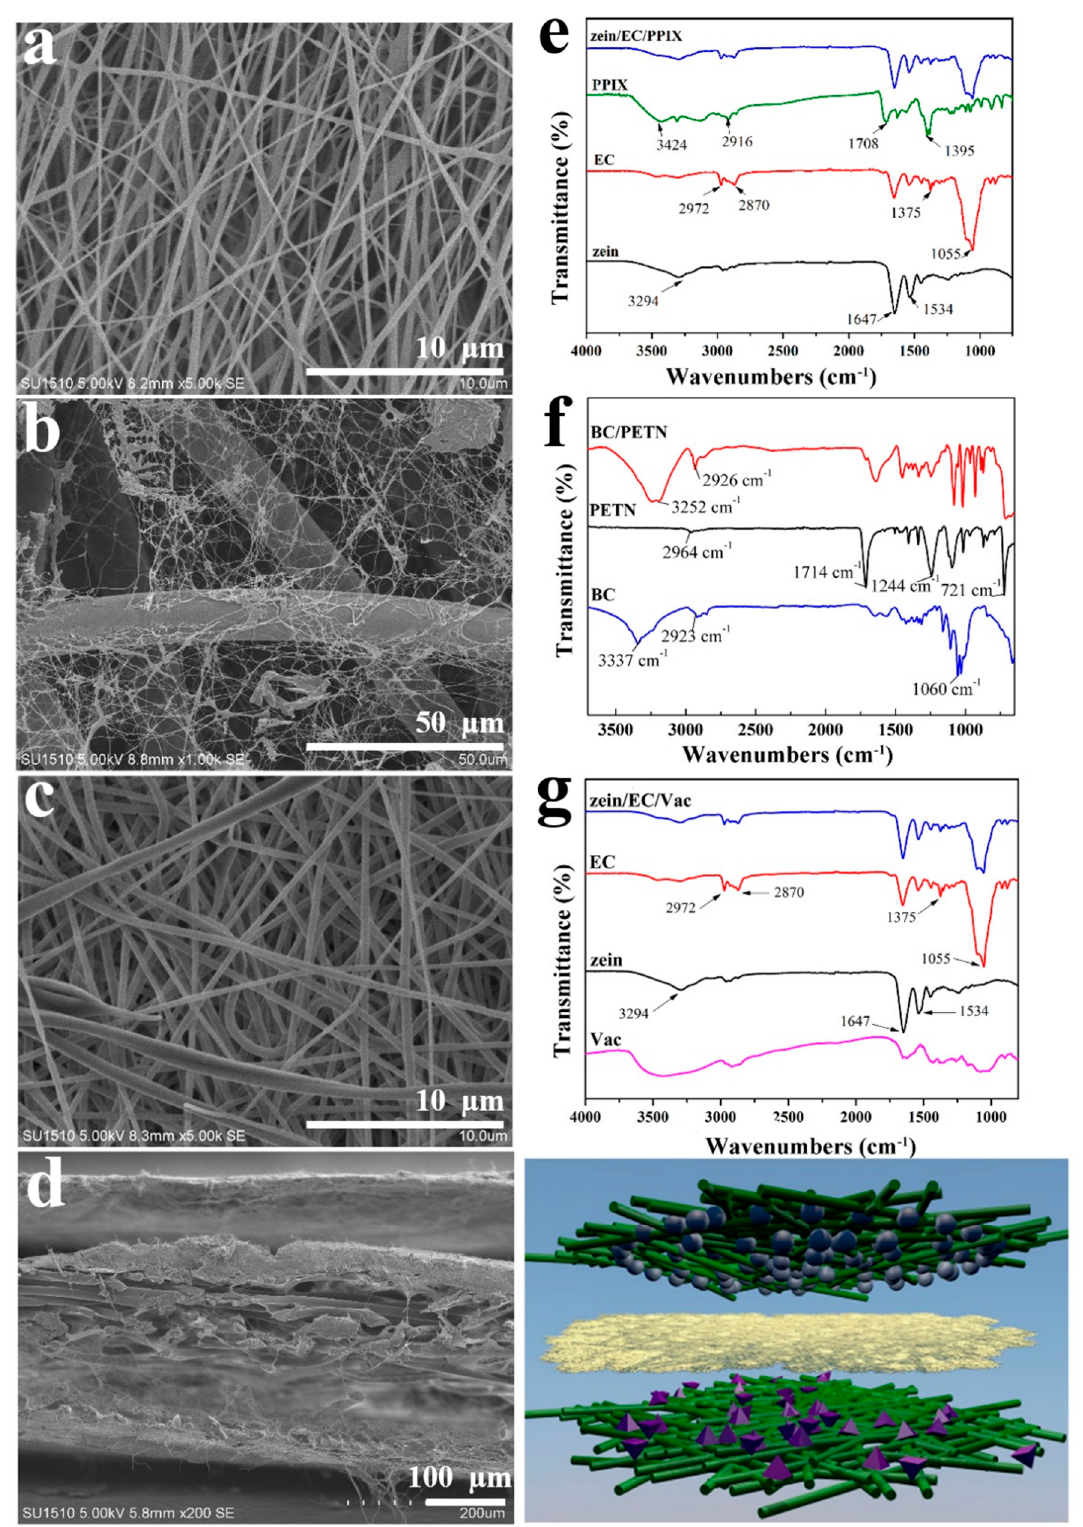
Figure 3. Scanning electronic microscope (SEM) images of the ABL ( a ), the RFL ( b ), the HPL ( c ), and the cross-section of the MC ( d ); FTIR spectra of the ABL ( e ), the RFL ( f ), the HPL ( g ), as well as raw materials.